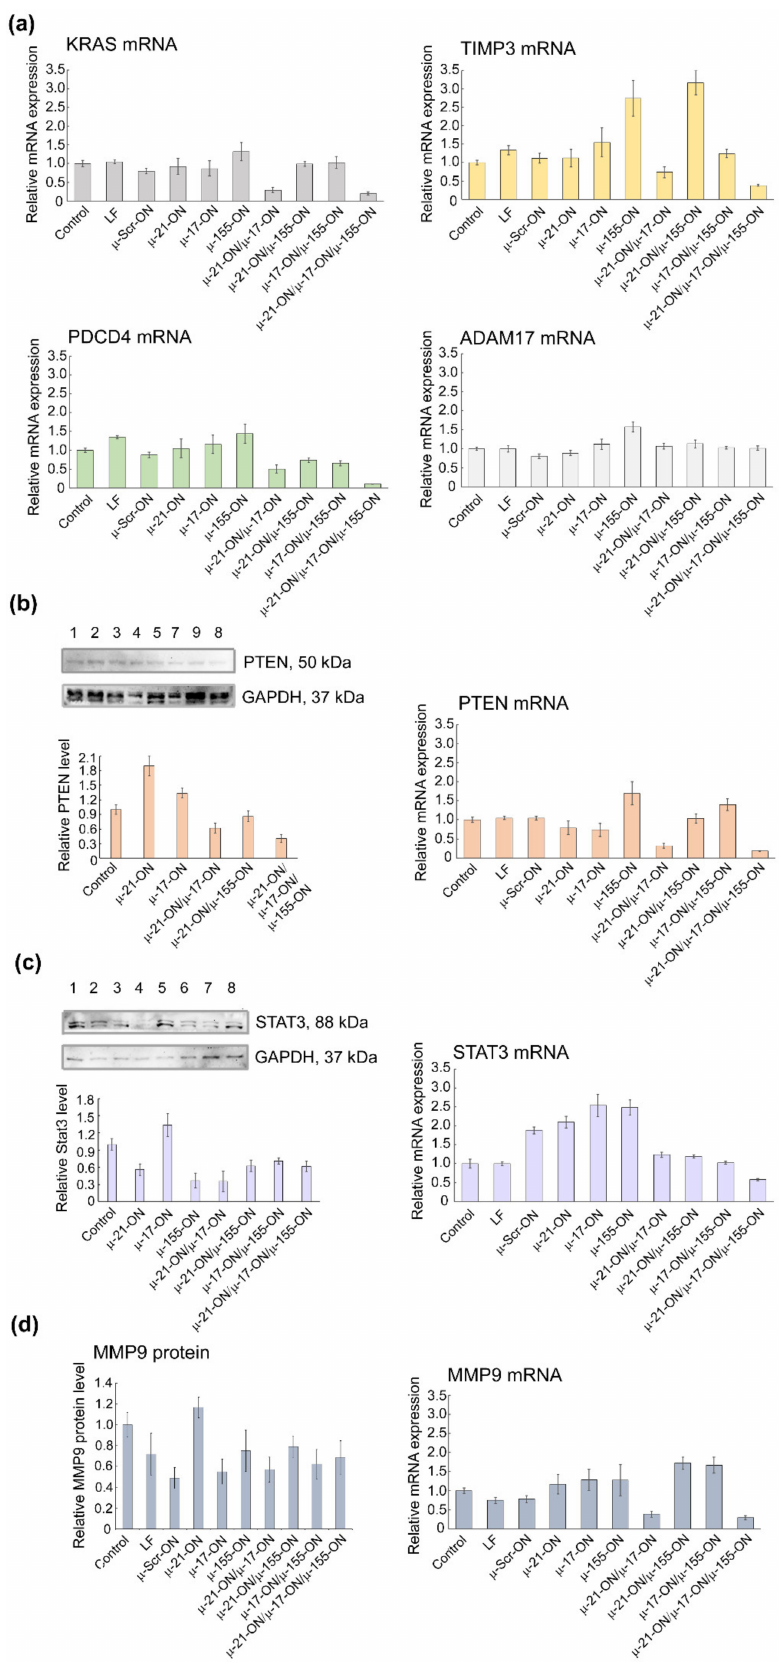
Figure 10. Analysis of mRNA and protein levels of genes, regulated by miR-21, miR-17 and miR-155 in murine lymphosarcoma RLS 40 cells after treatment with µ -oligonucleotides. ( a ) Relative